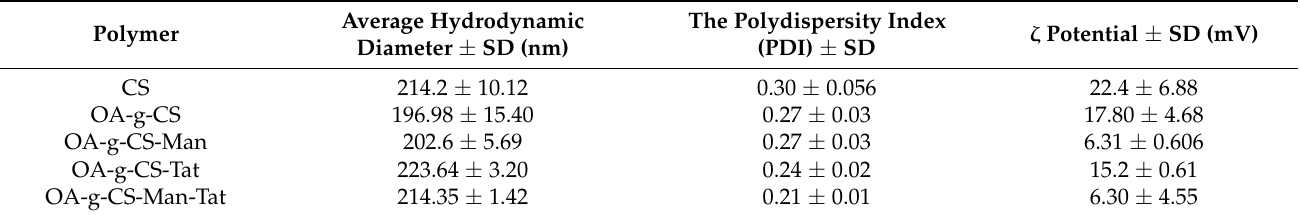
Table 2. Size distribution, zeta potential, and polydispersity index of the synthesized conjugates. Data shown as mean ±